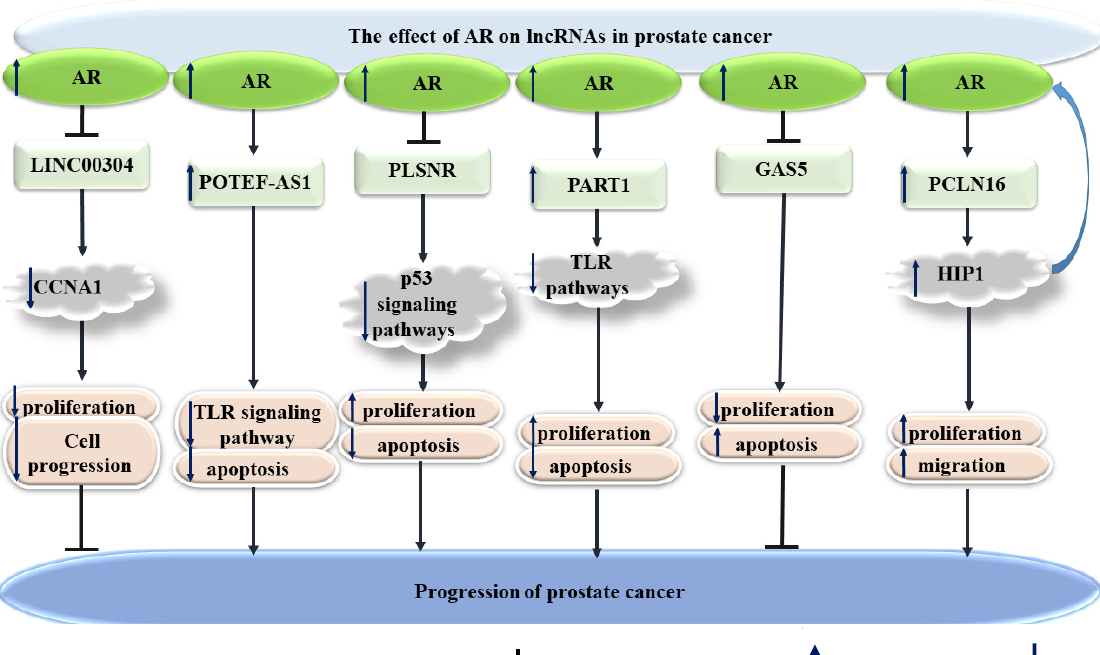
increased levels of, decreased